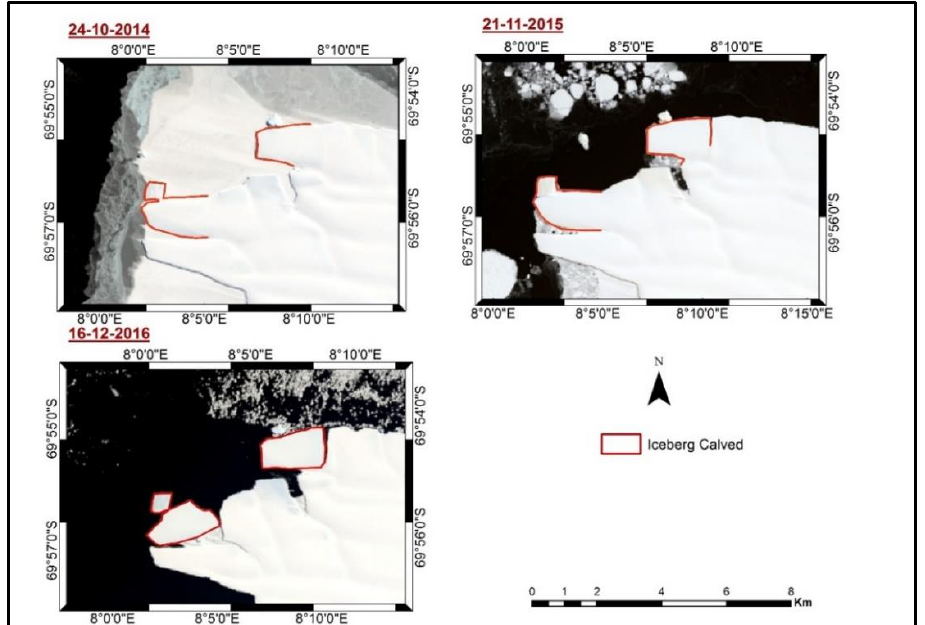
Figure 5. Calving event at Princess Astrid